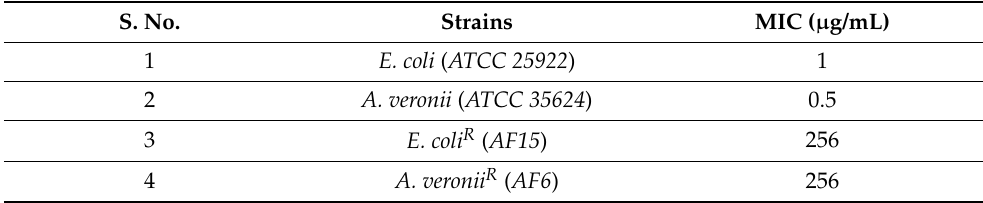
Table 1. MICs ( µ g/mL) of colistin tested against susceptible and resistant strains. S.